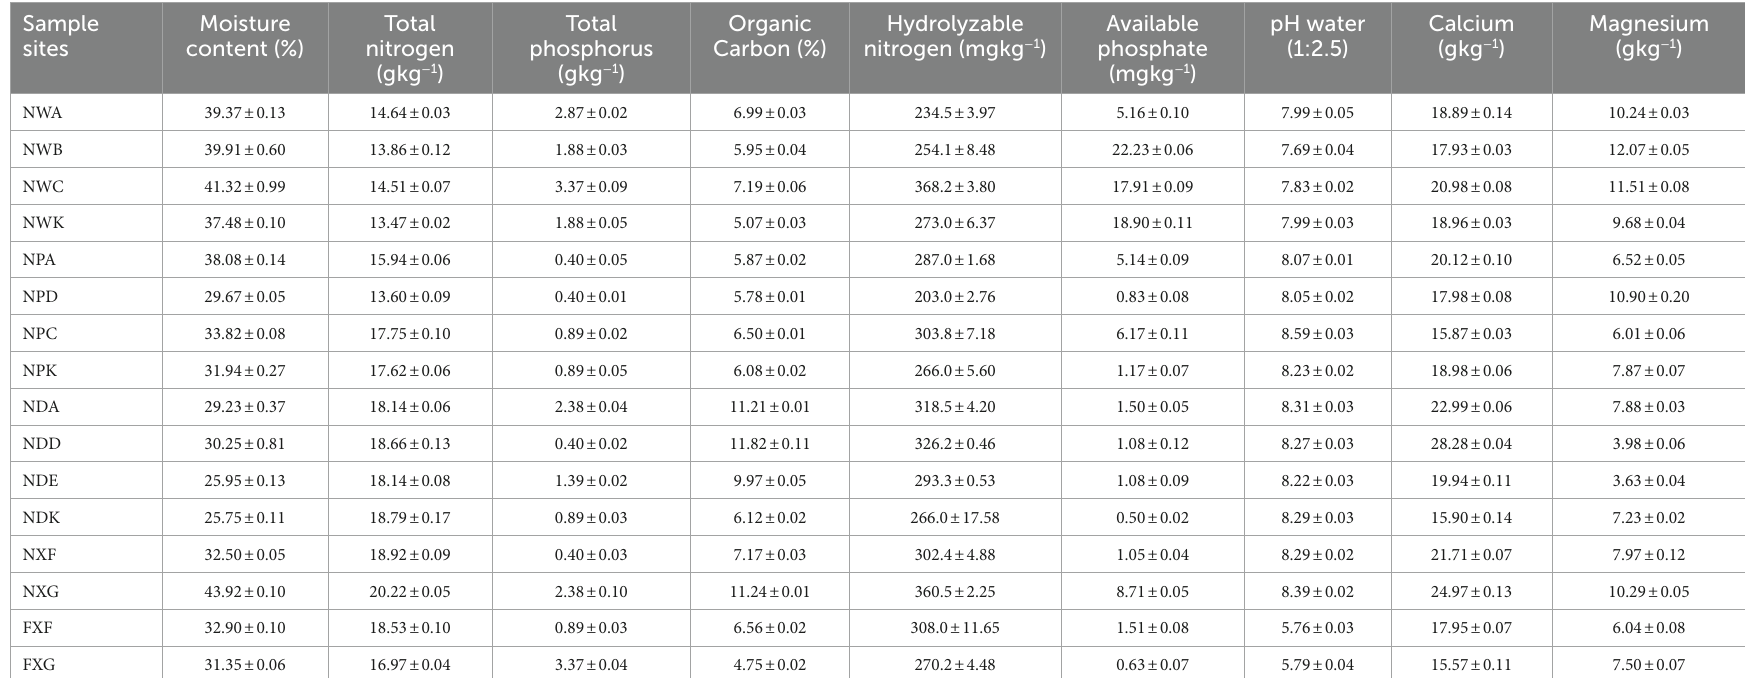
TABLE 2 Mean biogeochemical properties of samples collected in two plots. Sample